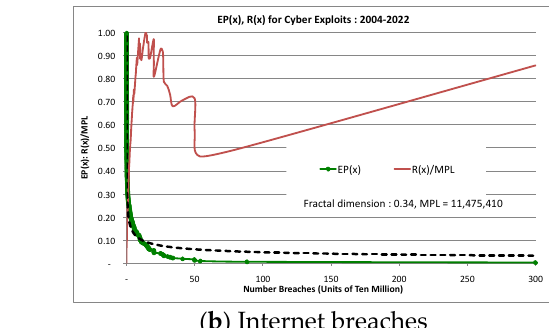
Figure 2. Simulated viral cascading of the links of the simple directed network in Figure 1 produces a green exceedance probability EP(x) with q = 0.97 and red risk R(x) curve with MPL as its maximum point. A seed link is selected randomly 10,000 times within 5 trials. ( a ). Plot of exceedance probability in green, the risk in red, and a logarithmic plot of the exceedance probability showing linear (power law) fit to EP, with exponential cutoff. ( b ). A heat map of the directed network showing V used in the simulation of viral cascades. Nodes/links are heat map colored according to vulnerability. Consequence vector X is not shown: X = {100, 100, 100, 100, 100} for links and {100, 100, 200, 100, 100} for nodes.